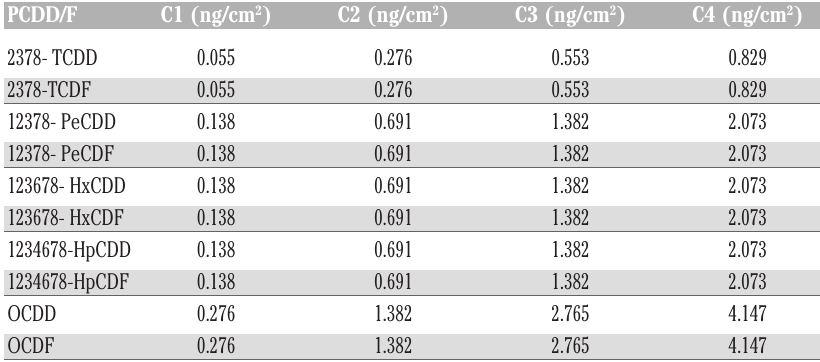
Table 3. Initial concentrations of polychlorinated dibenzo -p- dioxin/dibenzofuran in Petri dishes: in vivo exposure.